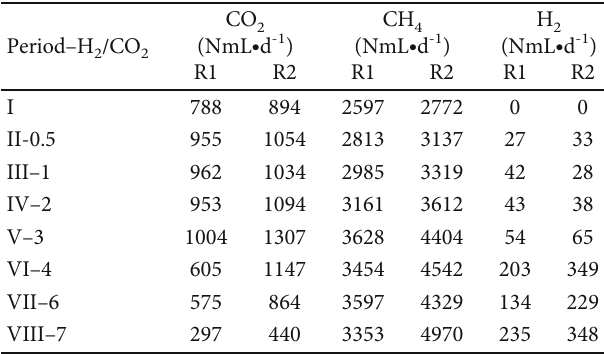
Table 3: Summary of reactors ’ gas mass fl ow (CO during the experimental